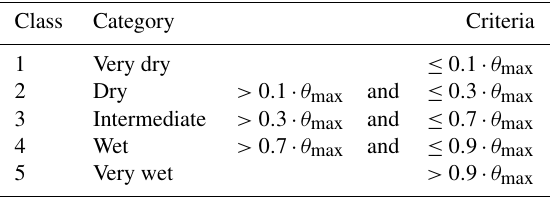
Table 3. Classes of soil volumetric water content (VWC) at 2.5cm depth, where θ max is the maximum of the 30min median values observed during the first hydrological year.